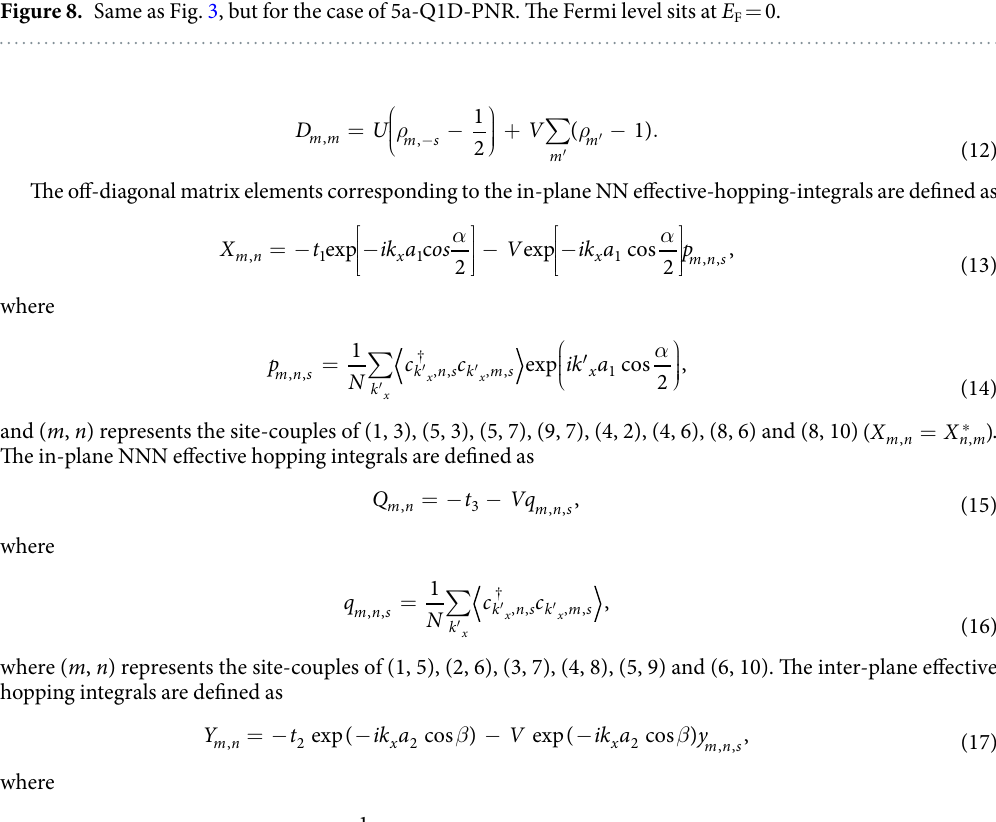
Figure 8. Same as Fig. 3, but for the case of 5a-Q1D-PNR. The Fermi level sits at E F =